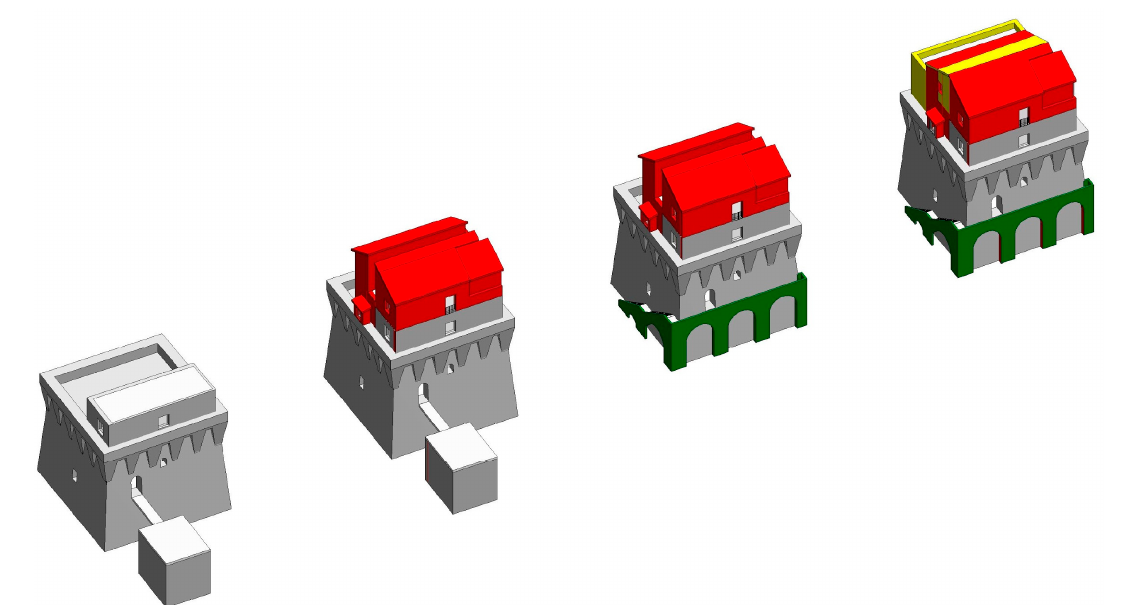
Figure 6. Evolution of the geometry of the Tower from 1540 to